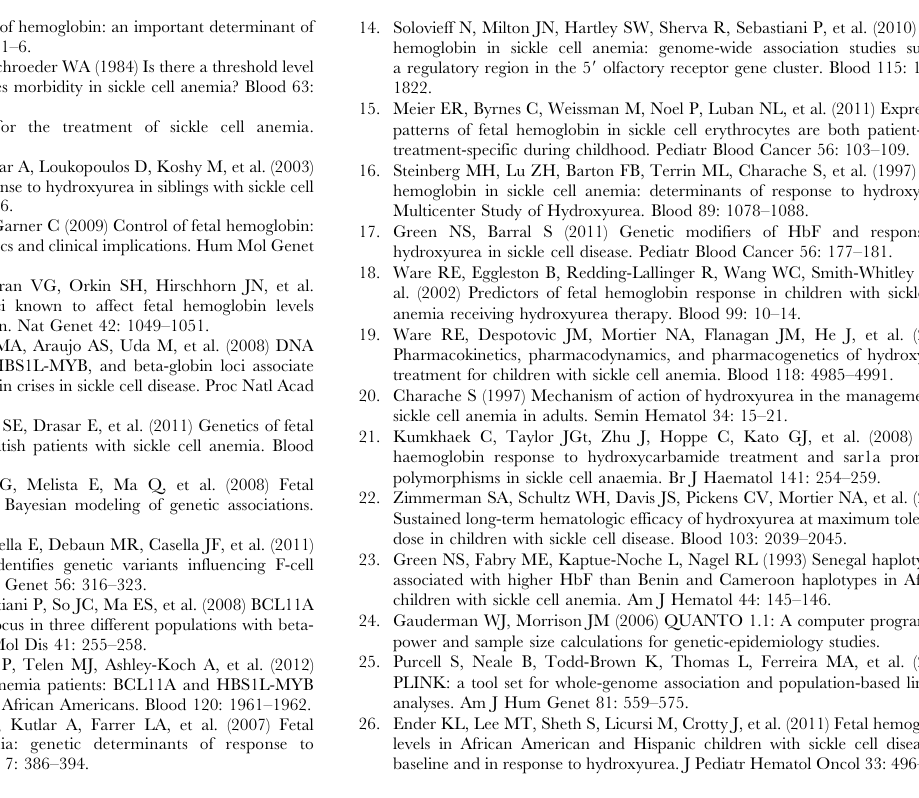
Table S1 Clinical and Genetic Data by Study Site. S1A. Clinical data by study site. S1B. Minor allele frequencies by study site. Table S2 HbF linear regression analysis to compare full model consisting of age, sex, individual and